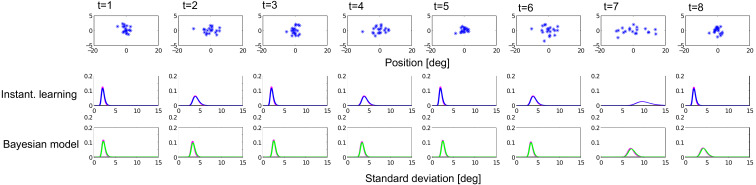
Comparing variational Bayes approximation with a numerical discretised grid approximation.Top row: Example visual stimuli over eight subsequent trials. Middle row: The distribution of estimated sample variance, with no learning over trials. Bottom row: The distribution of _V;t for the Bayesian model that incorporates the learning across trials. Red line is the numerical comparison when using a discretised grid to estimate variance, as opposed to the variational Bayes (green line).